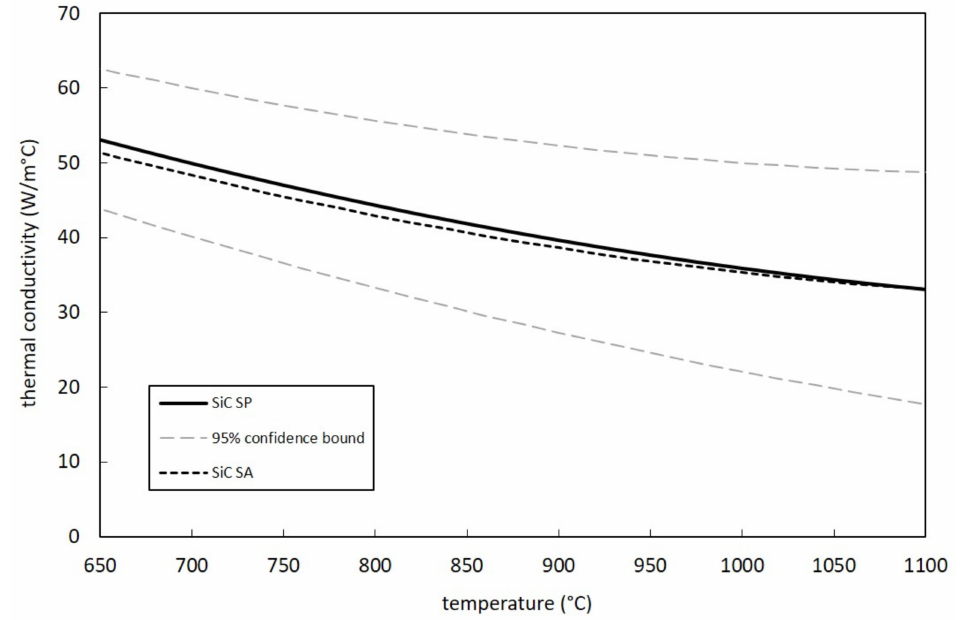
Figure 12. Measured thermal conductivity values for SiC SP samples and comparison with SiC SA